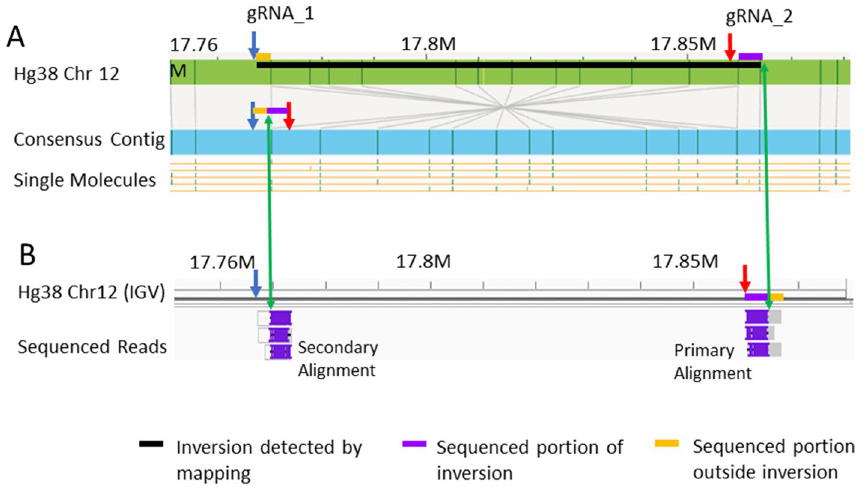
Figure 4. An inversion detected with optical mapping resolved with our cas9-assisted targeted nanopore sequencing approach. ( A ) Shows a black bar at the location where the inversion was detected on chromosome 12 contig by optical mapping. The blue and red arrows represent the gRNA pair designed to target this region. This gRNA pair is expected to generate a fragment represented by the yellow-purple bars. The yellow bar represents the part of fragment flanking the inversion while the purple represents the part of fragment inside the inversion. ( B ) Shows a set of sequenced reads aligning to this region. Coverage was 6×. They had distinct aligning and non-aligning segments as expected represented by the purple and yellow bars on the IGV reference respectively. The reads had a primarily alignment to hg38 on the right side of the inversion as expected in 3 ′ to 5 ′ orientation starting from the one designed gRNA cut site. The same reads showed a secondary alignment on the left side of inversion with an inverted orientation as expected also from a designed cut